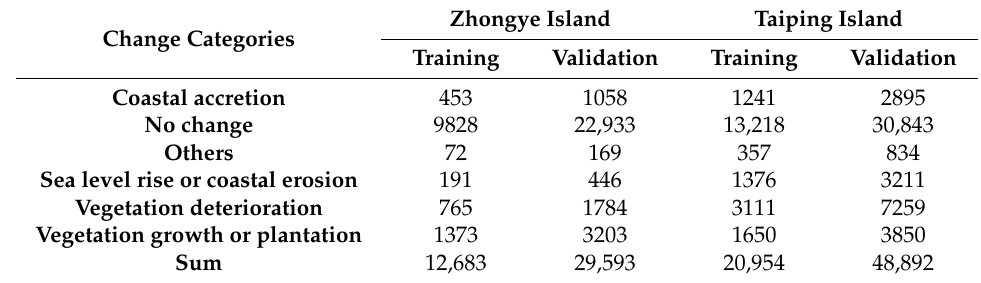
Table A6. The pixel sample numbers of all change categories in Zhongye Island and Taiping Island. Change Categories